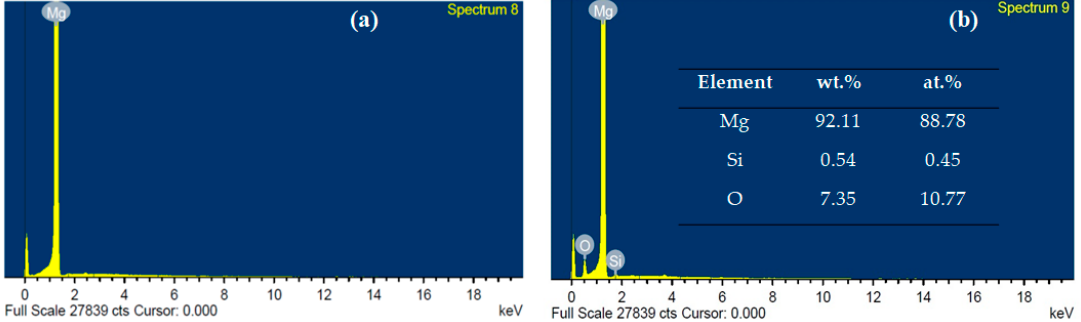
Figure 6. Energy dispersive X-ray spectroscopy (EDX) spectra of as-cast ( a ) pure Mg and ( b ) Mg/Mg-20GMB hybrid composite (the inset shows the element content).